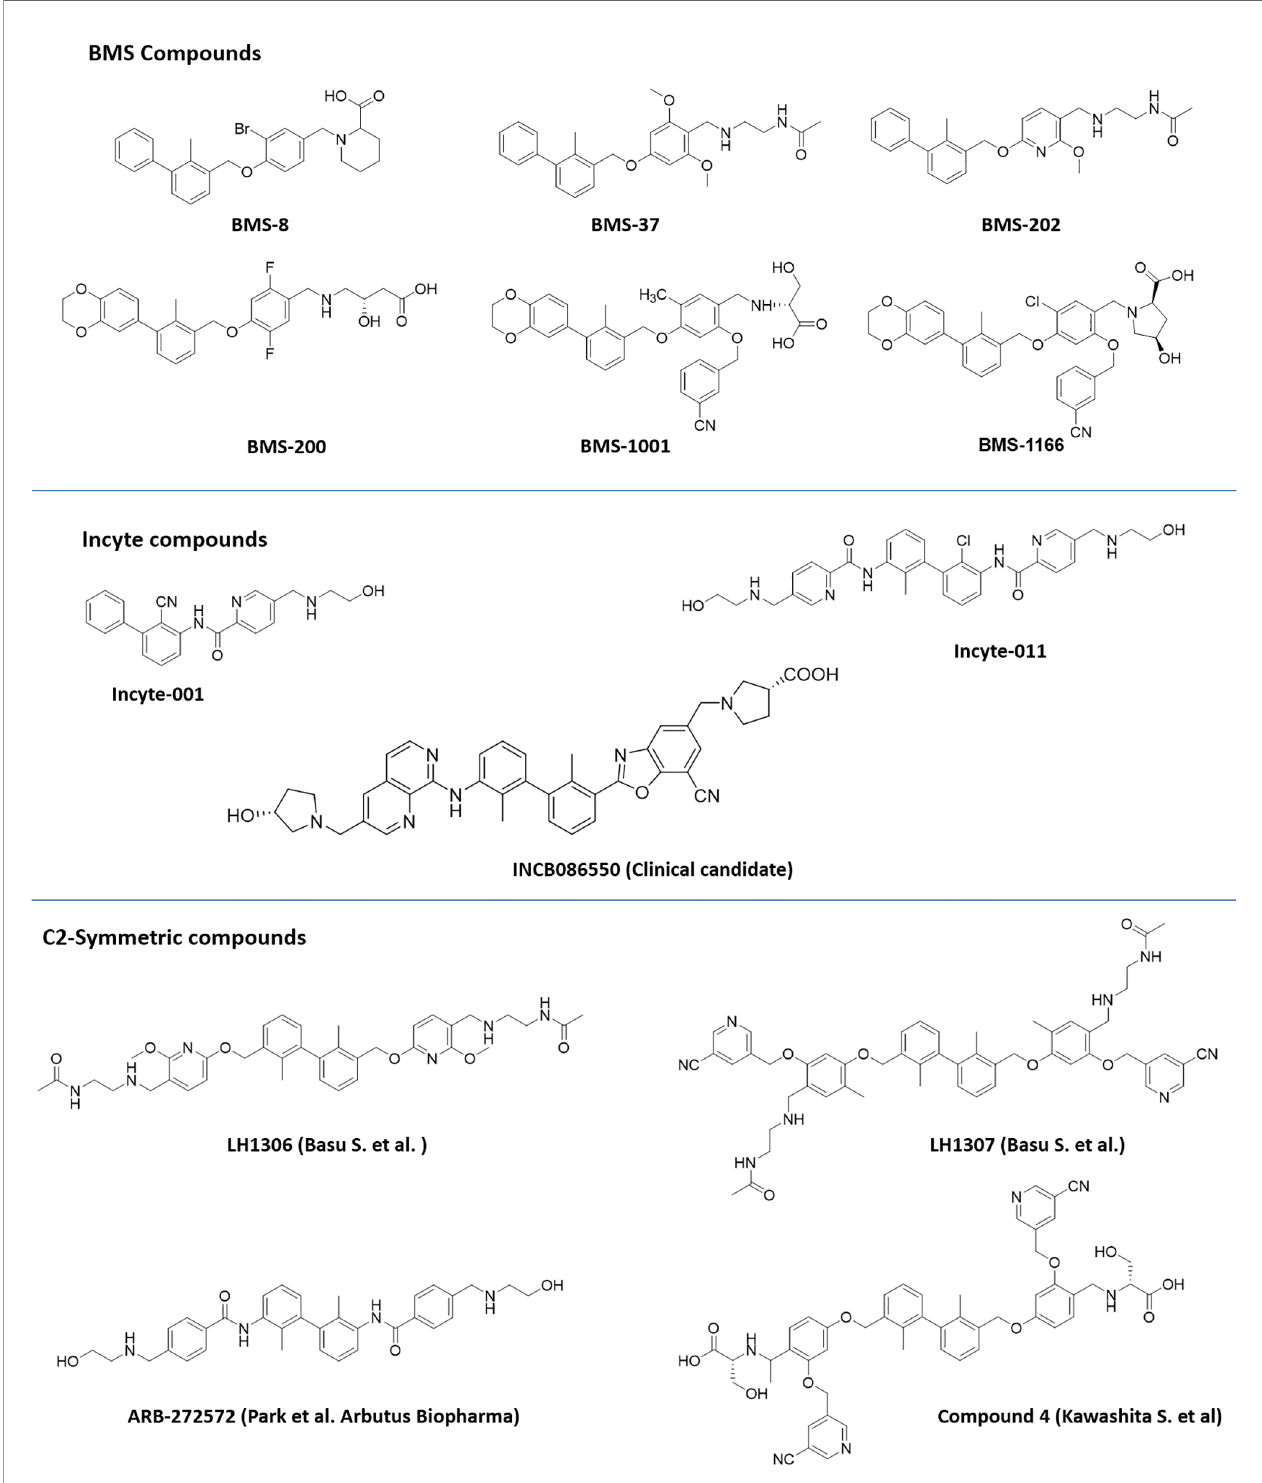
FIGURE 2 | Representative structures of fi rst-generation biphenyl derivatives and C 2 symmetric compounds targeting